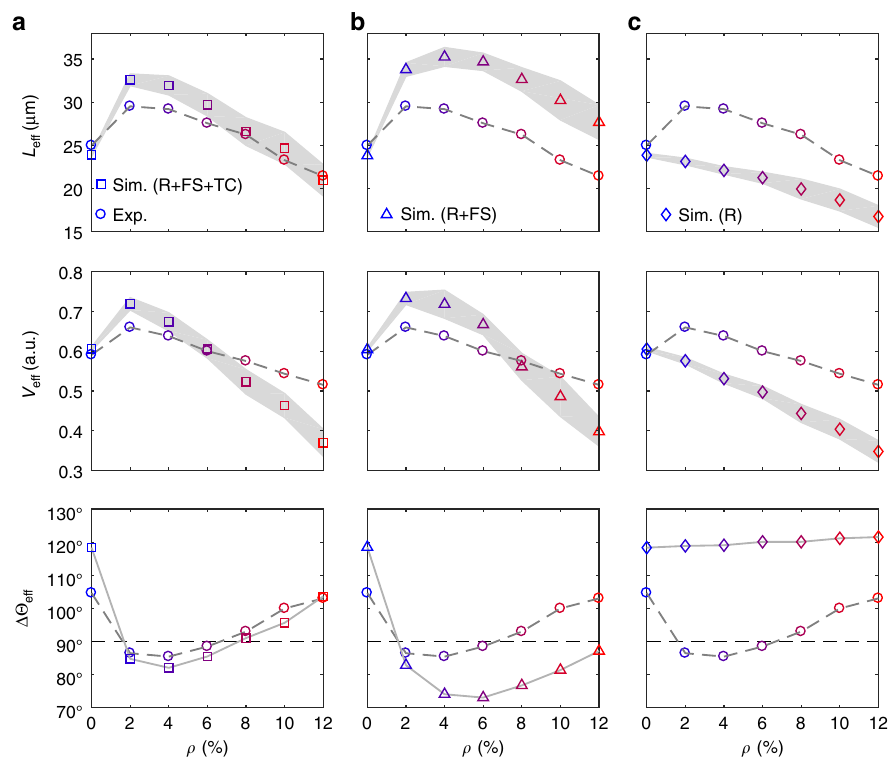
Fig. 5 Comparison between experiments and numerical simulations. a – c Simulated average effective propagation distance L eff , normalised average effective propagation speed V eff and average change in effective propagation direction ΔΘ eff as a function of the obstacle density ρ for chiral active particles self- propelling through a circular area of radius R = 25 μ m containing obstacles distributed at random without overlap (Supplementary Fig. 5a). The particles self-propel in the presence of a all three cell – obstacle interaction terms (R: repulsive interaction; FS: forward scattering; TC: tumble-collisions), b without tumble-collisions (TC) and c with repulsion (R) alone (Methods). Each value is obtained from averaging over 3000 different trajectories. The shaded area around the mean values of L eff and V eff represents one standard deviation. The solid line connecting the values of ΔΘ eff is a guide for the eyes. The corresponding probability distributions of the change in effective propagation direction Δ θ eff are shown in Supplementary Fig. 6. The corresponding experimental values (Figs. 1 and 2) are shown for reference (circles). Supplementary Figure 7 shows simulations where only repulsion (R) and tumble- collisions (TC) are to a few obstacles is also con fi rmed by the higher value of the measured translational diffusion coef fi cient D , as estimated from the asymptotic behaviour of the cells ’ mean square displacement (Fig. 8 and Methods): when compared to a smooth surface, the ¼ 1 : 55 ( D = cell ’ s diffusivity is indeed enhanced by a factor D 2 % 0% D 0 % 42.82 μ m 2 s − 1 and D 2% = 66.58 μ m 2 s − 1 ).